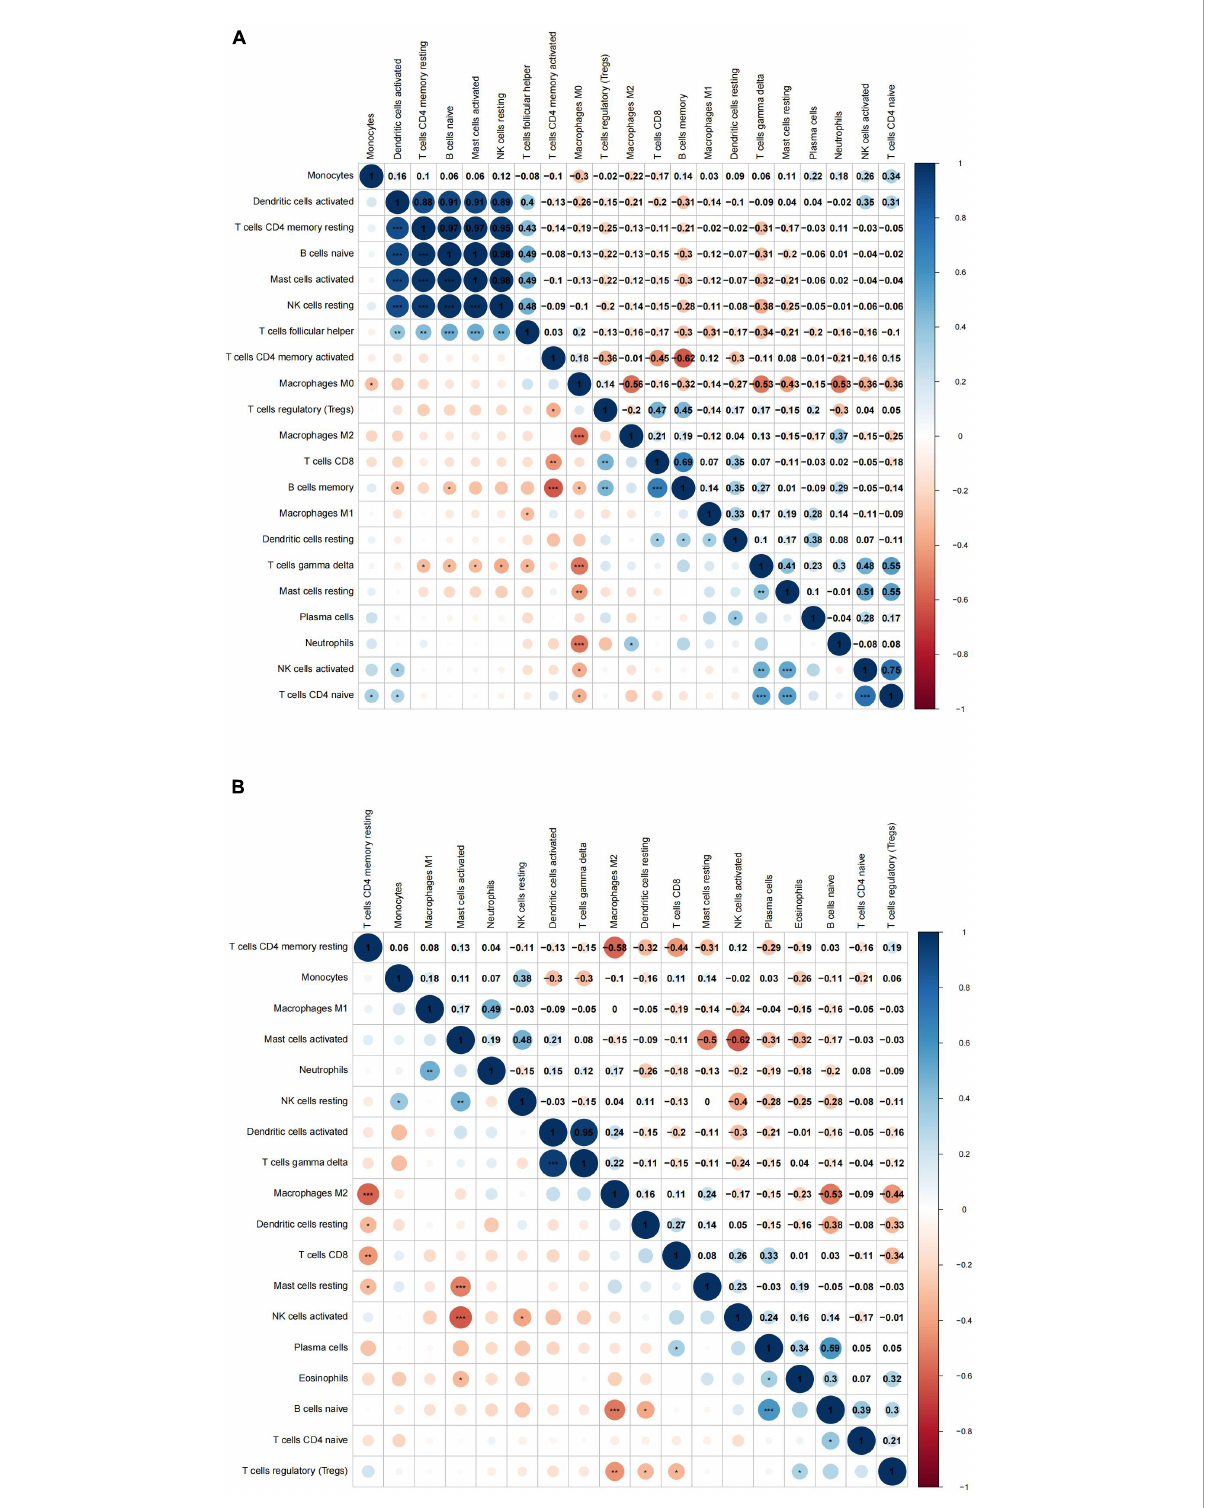
FIGURE6 The correlation analysis between 22 immune cell types in the carotid atherosclerotic plaques and vascular dementia (VaD) datasets. (A) Heat map of the correlation between 22 immune cell types in the carotid atherosclerotic plaques dataset. (B) Heat map of the correlation between 22 immune cell types in the vascular dementia dataset. Significance level was denoted by * p -value < 0.05, ** p -value < 0.01, *** p -value <